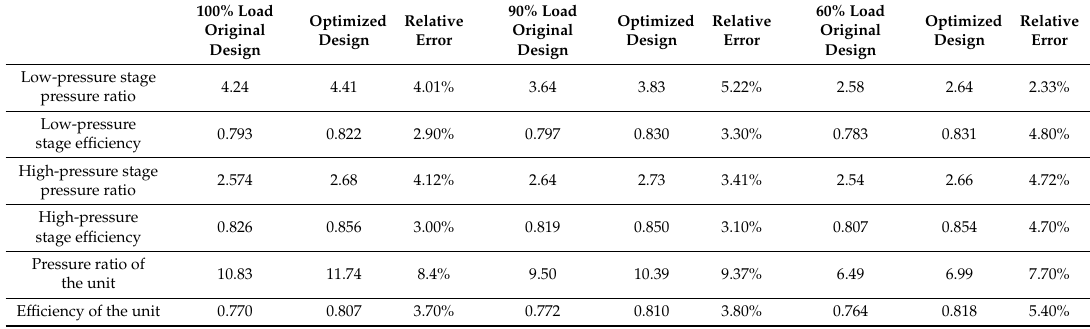
Table 6. Computational fluid dynamics (CFD) calculation results of the MW-level gas